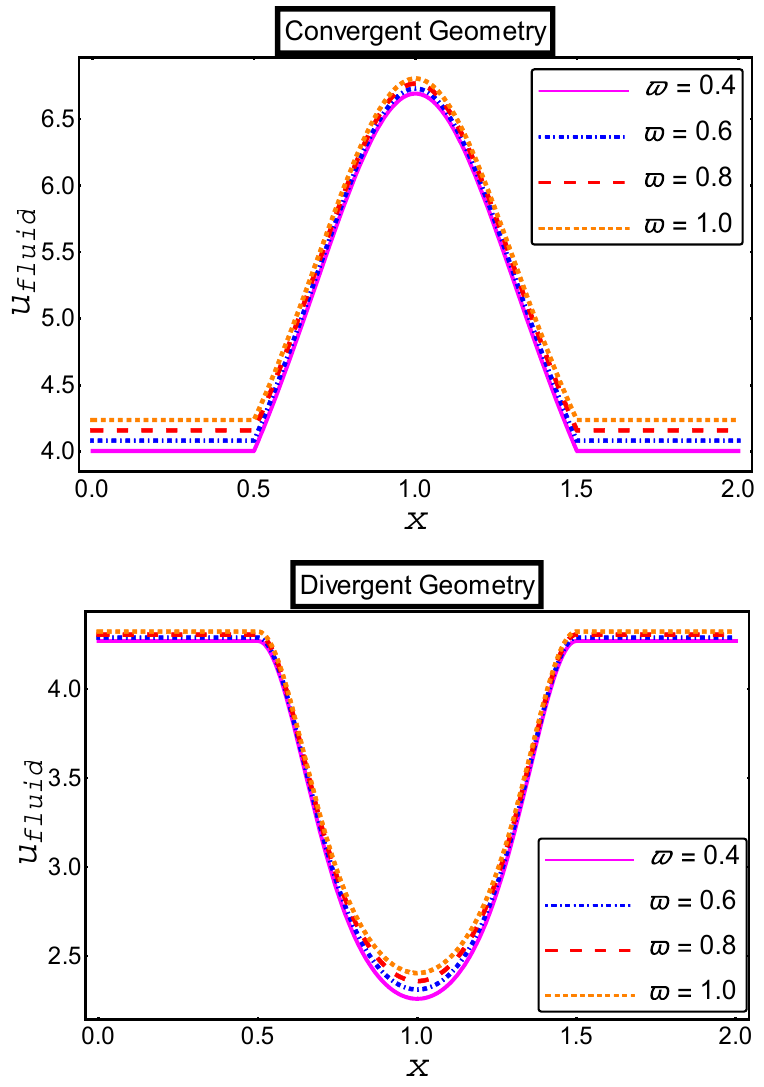
Figure 3. Impact of fourth-grade parameter on fl uid velocity.